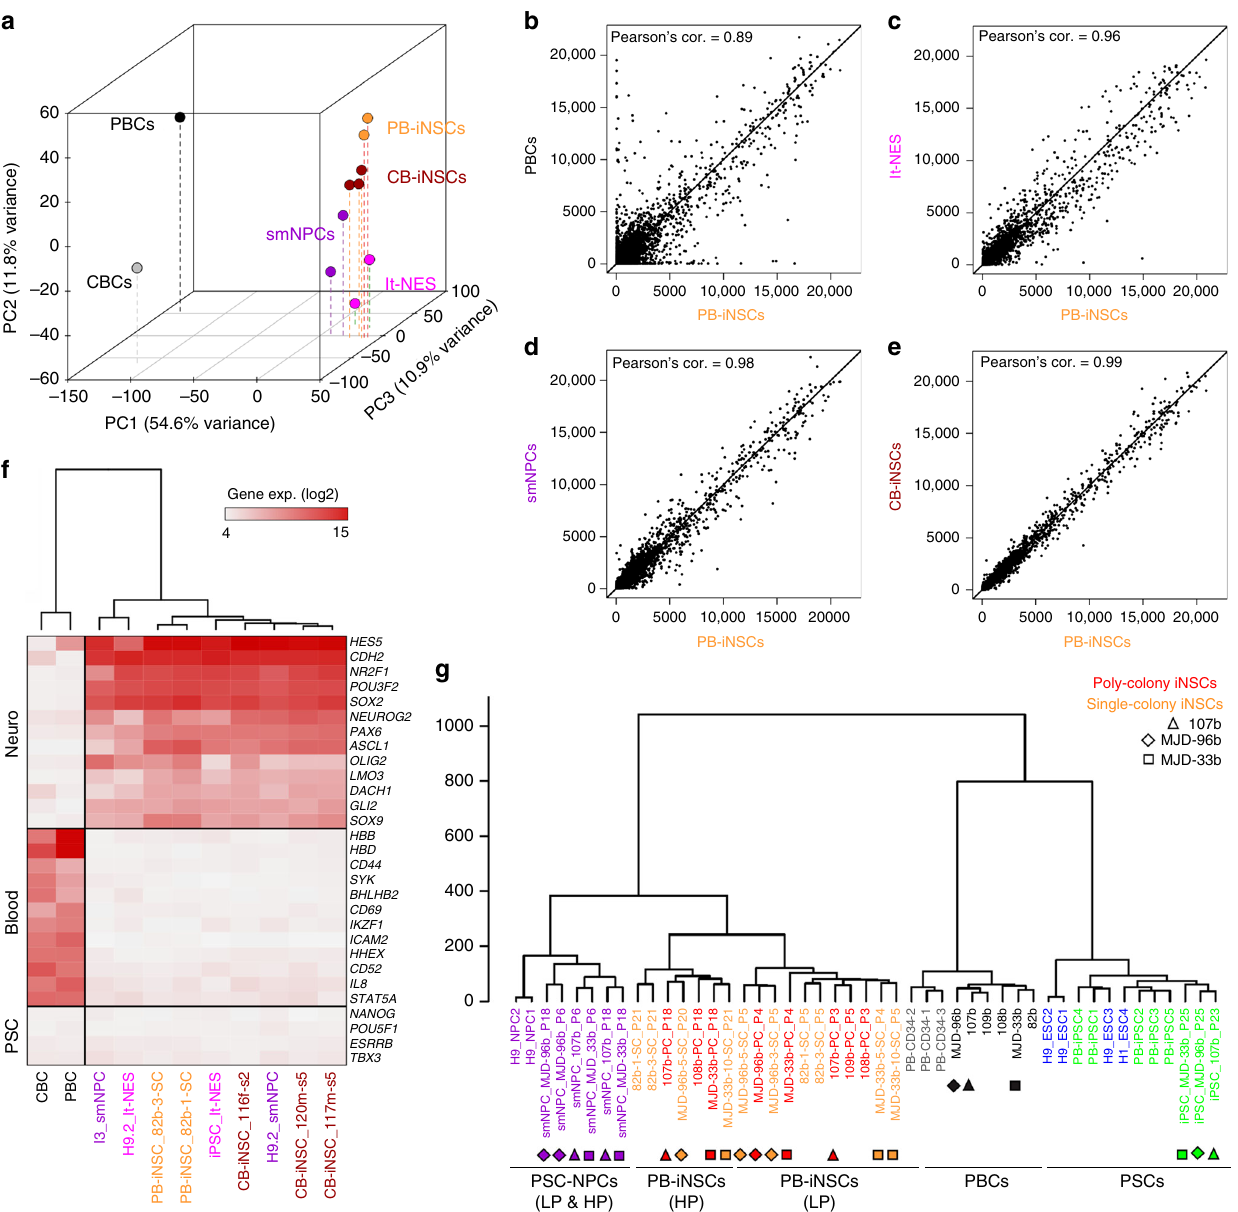
Fig. 4 Global gene expression and DNA methylation analysis. a Principal component analysis indicates that both PB-iNSCs and CB-iNSCs exhibit global gene expression pro fi les similar to those of their PSC-derived counterparts, but clearly distinct from their parental blood cells. b – e Scatter plot analysis of global gene expression pro fi les shows that PB-iNSCs are very distinct from PBCs ( b ). PB-iNSCs resemble lt-NES ( c ) and display a particularly high similarity to smNPCs ( d ). PB-iNSCs show a high degree of similarity with CB-iNSCs ( e ). Principal component analysis ( a ) and pair-wise scatterplots ( b – e ) were done genome-wide including 31,427 genes without fi ltration. f Heatmap of selected genes representative for neural, hematopoietic, and pluripotent cells reveals the expression of genes speci fi c to the neural lineage in iNSCs. The clustering of different cell populations is based on the selected genes shown in the heatmap. g Hierarchical clustering of global DNAm pro fi les (485,512 CpGs) shows that the DNAm pro fi les of iNSCs are similar to those of PSC-derived NPCs and very distinct from PBCs and PSCs. The y -axis represents the height of dendrogram calculated using Euclidean distance and Ward's linkage method. PC: principle component; CBCs: CB-CD34 + cells; LP: low passages; HP: high passages. Triangles, diamonds, and squares indicate